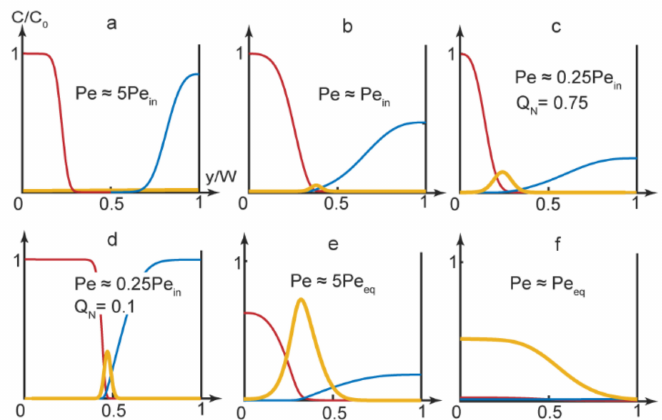
Figure 3. Numerical simulations results at the main channel end (x = L) for the PDADMAC-SDS complexation reaction. Concentration curves: blue—PDADMAC, red—SDS, yellow—complex. Flow rates: ( a ) A, B—5 µ L/min, solvent—10 µ L/min; ( b ) A, B—5 µ L/min, solvent—3 µ L/min; ( c ) A, B—0.2 µ L/min, solvent—1.2 µ L/min; ( d ) A, B—10 µ L/min, solvent—2 µ L/min; ( e ) A, B, solvent— 1 µ L/min; ( f ) A, B, solvent—0.1 µ L/min. The main channel width = 300 µ m and length = 15